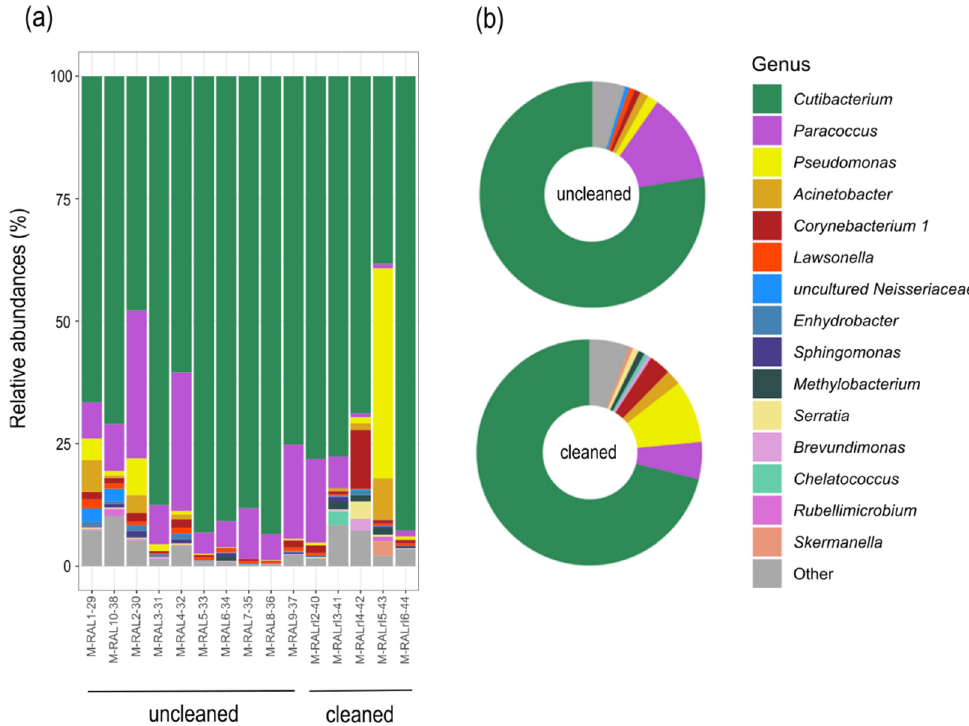
Figure 3. Stacked barplots of the relative abundances on genus level of uncleaned ( n = 10) and cleaned ( n = 5) microscope oculars: ( a ) Each bar represents one ocular sample; ( b ) Samples merged to pie charts for the factor ’uncleaned’ and ’cleaned’, representing the uncleaned and cleaned oculars. To facilitate comparison, only taxa with a relative abundance of >0.5% are displayed, the remaining taxa were summarized as ‘Other’.